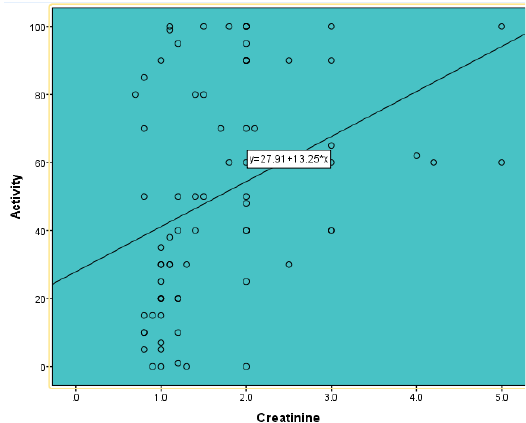
Figure 1. Correlation between serum creatinine and glomerular activity